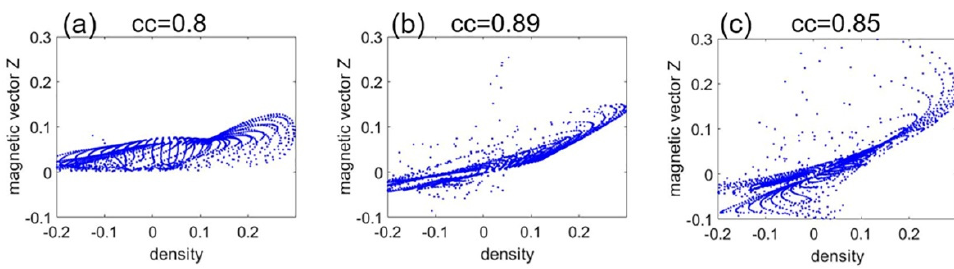
Figure 9. Model parameter cross plots shown in Panels ( a – c ) correspond to the standalone inversions,